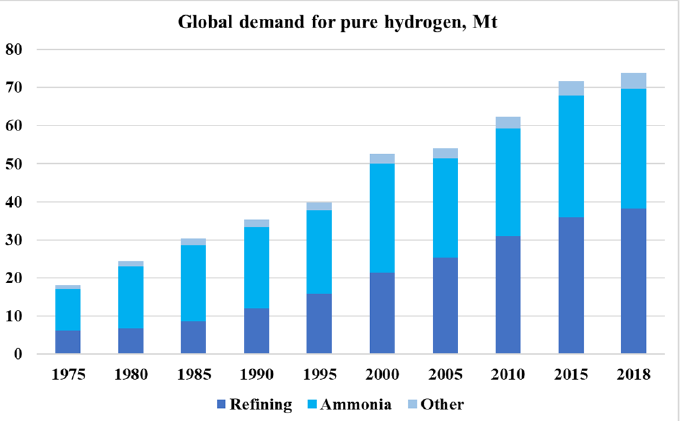
Figure 14. Global demand for pure hydrogen, Mt, 1975–2018 [49].